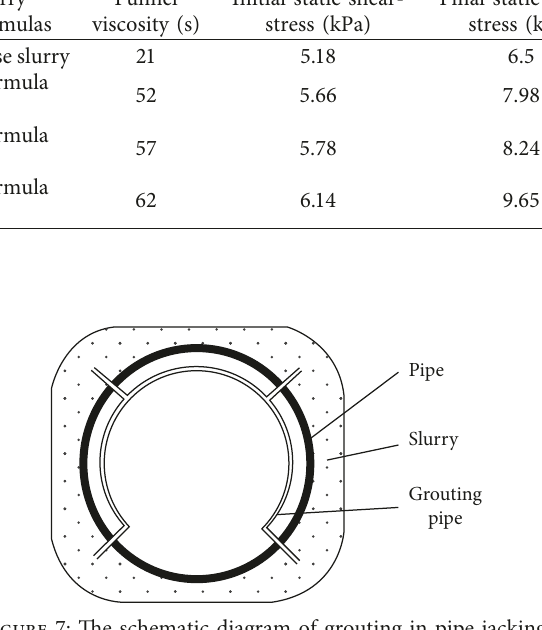
8: The schematic of diagram the pipe-soil and pipe-slurry combinative contact model